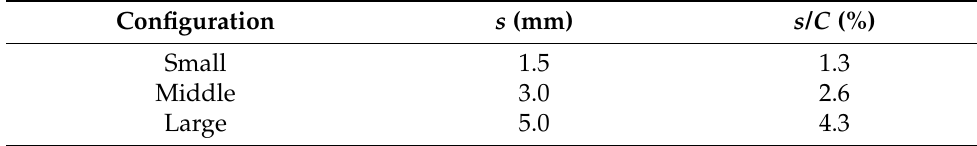
Table 2. Summary of blade tip